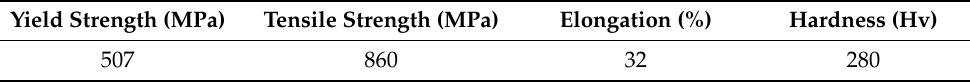
Table 4. Artificial cracks of wheel